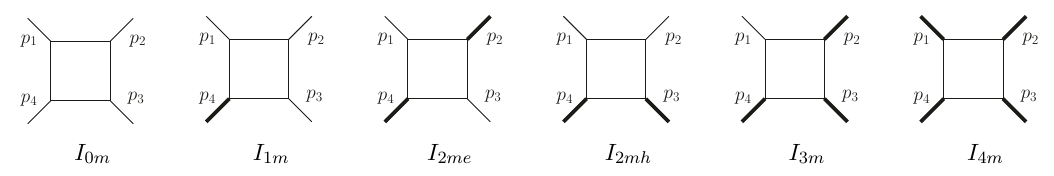
Figure 2 . 6D box integrals. Thick external legs are o(cid:11)-shell and thin are on-shell momenta. we show that the conformal symmetry of the o(cid:11)-shell integral is in general spoiled by the collinear anomaly of the trivalent vertices with one massless